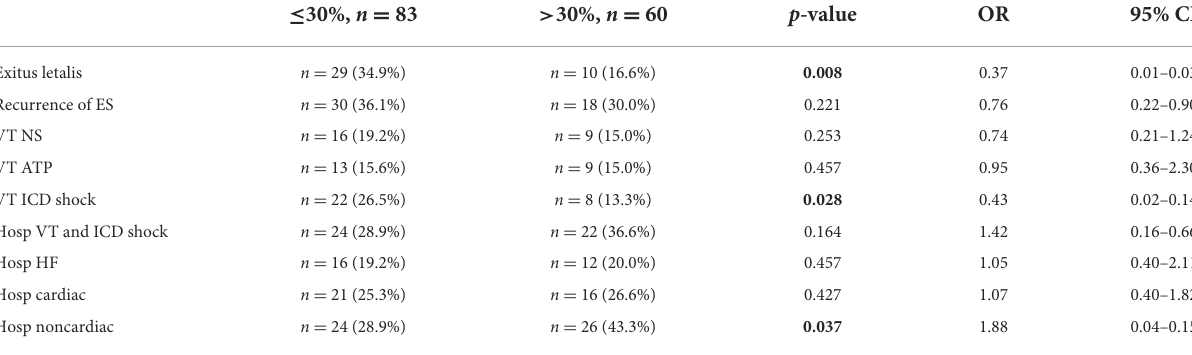
TABLE 5 Analysis between LV EF ≤ 30 vs. > 30%.